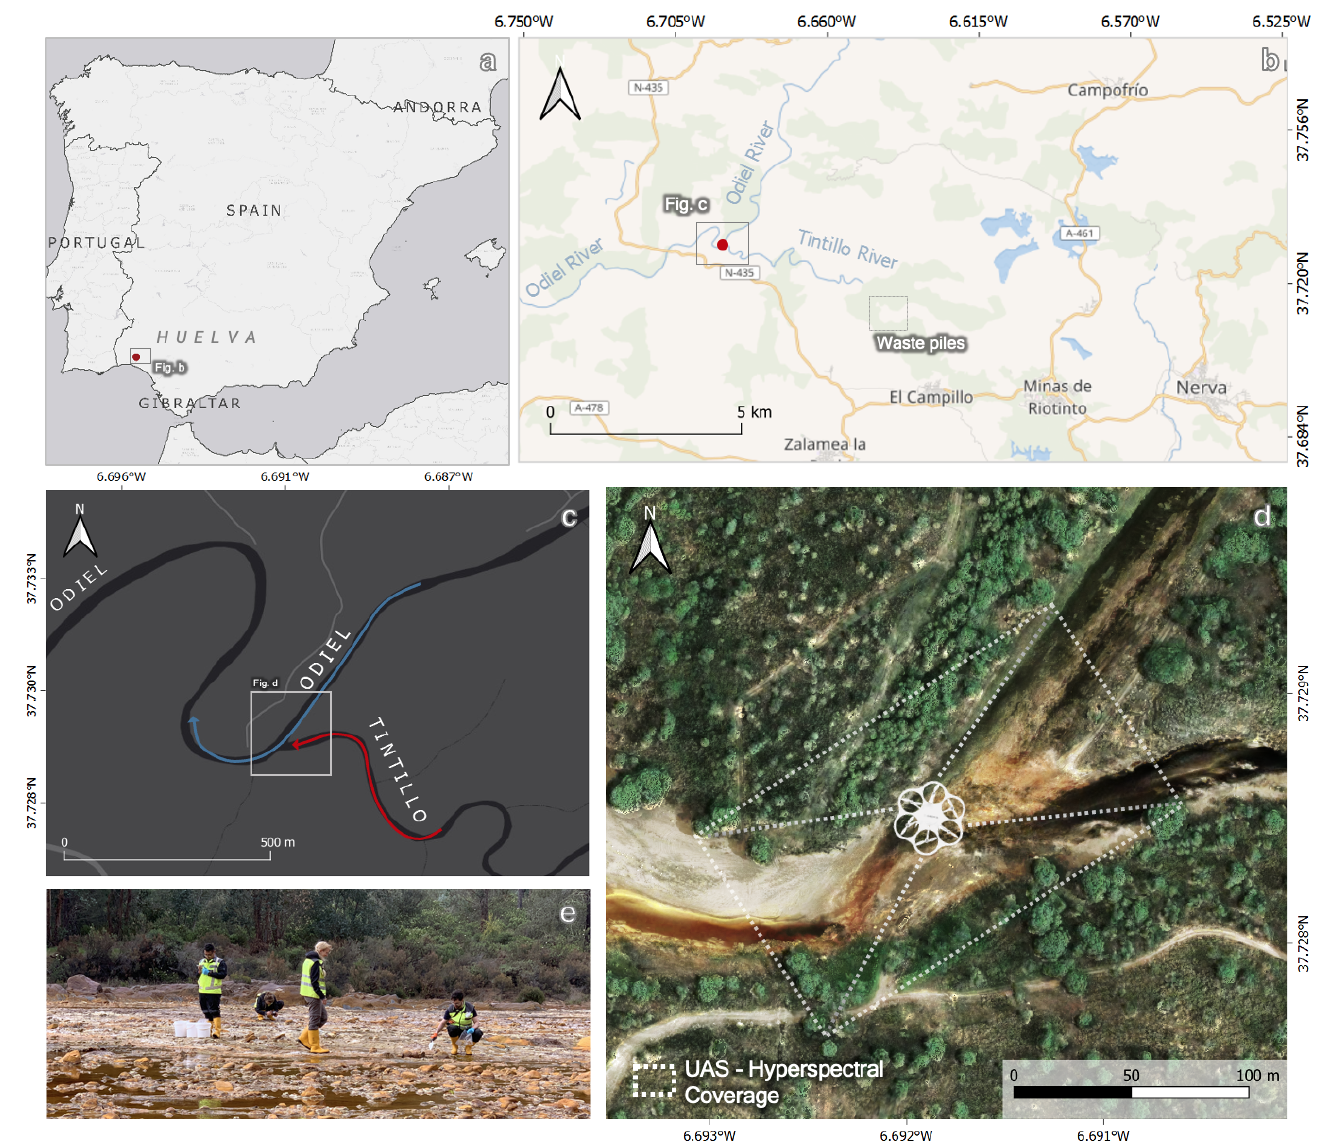
Figure 1. ( a – c ) Location of the investigated area in the Odiel River (Huelva, Spain). ( d ) Orthophoto of the Odiel-Tintillo confluence showing the unmanned aerial system (UAS)-borne hyperspectral scanned scene. ( e ) Panorama of the field sampling campaign and members of the HZDR-HIF—Exploration Department in the test